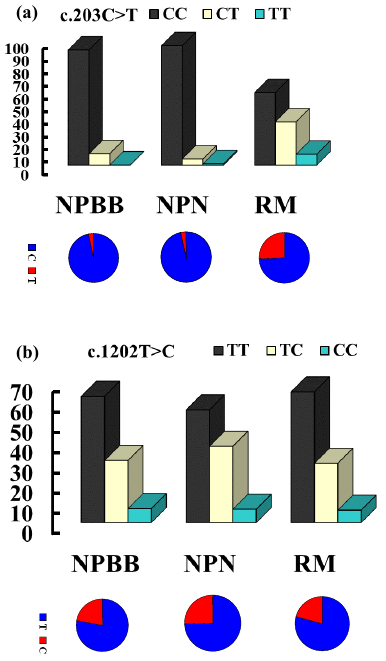
Figure 2. The genotype and gene frequencies of the SNPs c.203C > T (a) and c.1202T > C (b) from the TYRP1 gene in Nan- ping black-boned (NPBB), Nanping normal (NPN) and Romney Marsh (RM) sheep.